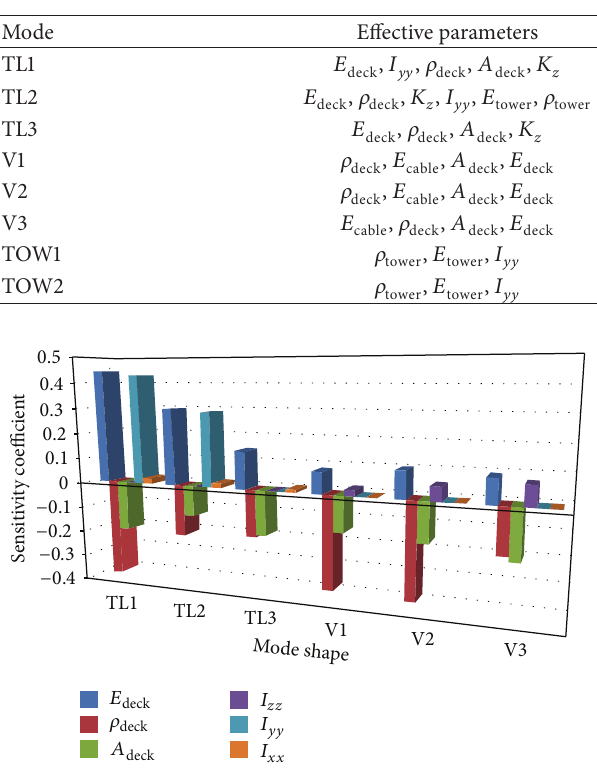
Figure 7: Sensitivity of modes to the parameters of steel